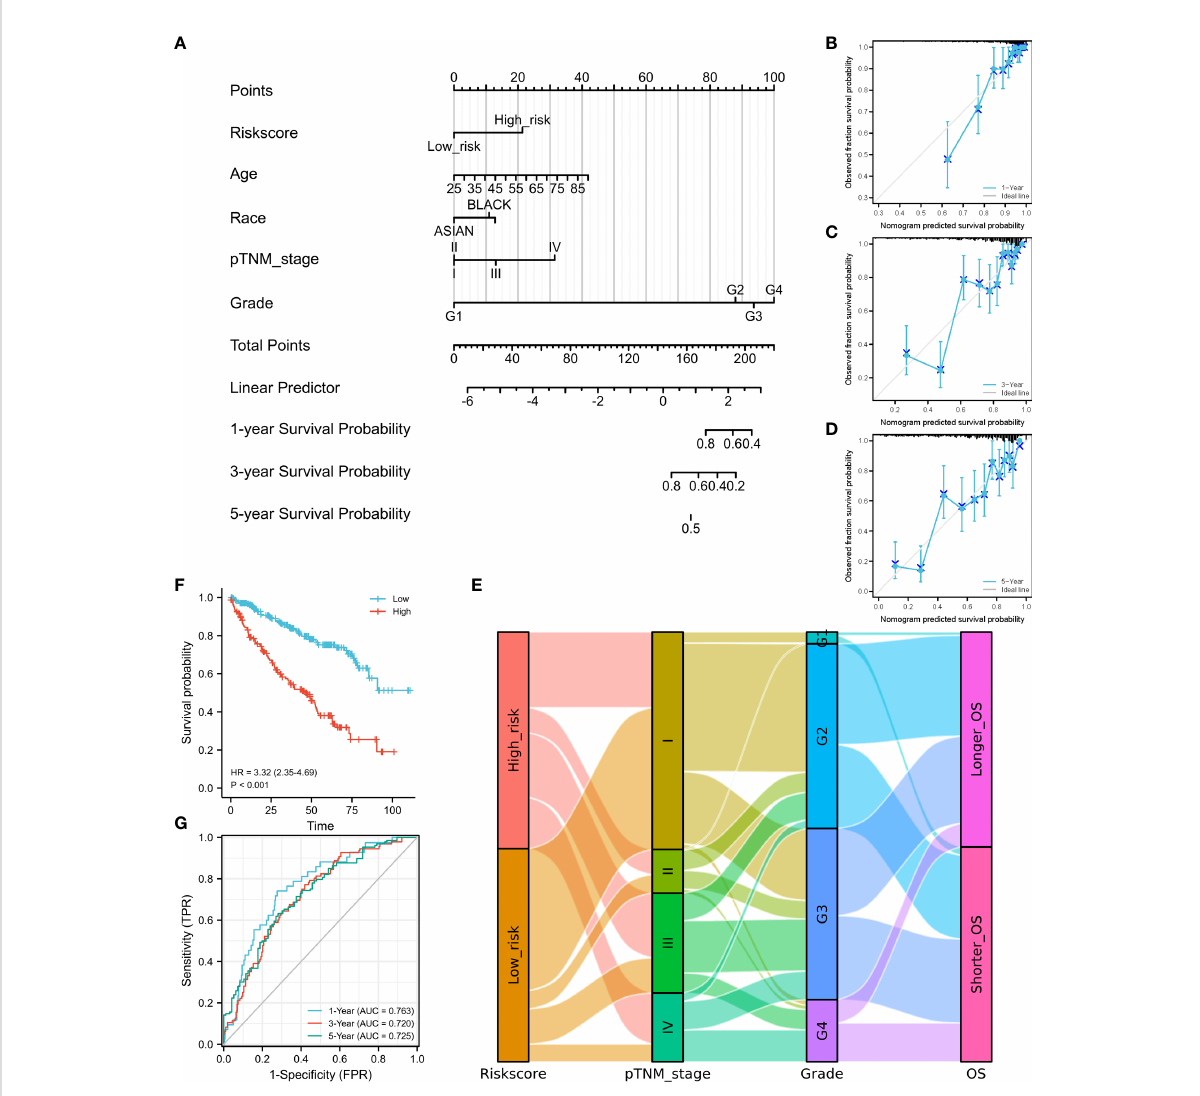
FIGURE 3 Construction of a nomogram and independent signature validation. (A) Nomogram for predicting 1-, 3-, or 5-year OS in patients with ccRCC. (B) The calibration plots for predicting 1-year OS. (C) The calibration plots for predicting 3-year OS. (D) The calibration plots for predicting 5- year OS. E Sankey diagram showing the association between signature risk scores and clinicopathological characteristics. (F) Validation of the signature in overall survival based on data from the cBioPortal online database. (G) The ROC curves of the signature validation for overall survival at 1, 3, and 5 years. OS, overall survival; ROC, receiver operating